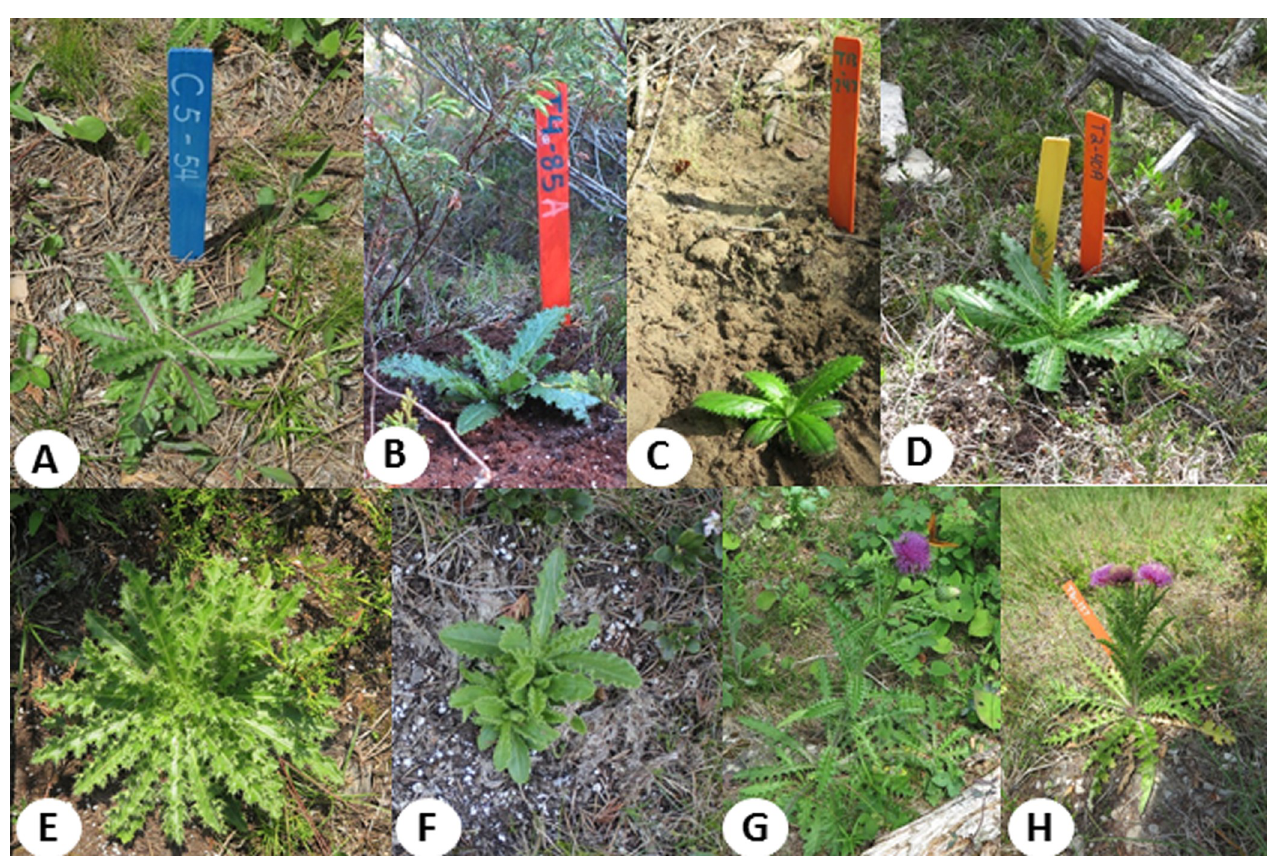
Fig 4. Natural sites of Hill’s thistle were selected where natural population existed (A). Micropropagated Hill’s thistle plants were transplanted on June 2017 (B) and July 2017 (C) on 12 different sites at the National Park in Tobermory, ON, Canada. Micropropagated plant growth and development were observed after one month and three months of transplanting (D and E). Multiple shoots were observed after winter survival of micropropagated Hill’s thistle plants in May 2018 (F). Flowering with well-formed flowerheads observed in the natural (G) and micropropagated plants (H) in July 2018 with multiple flowerheads on micropropagated plants